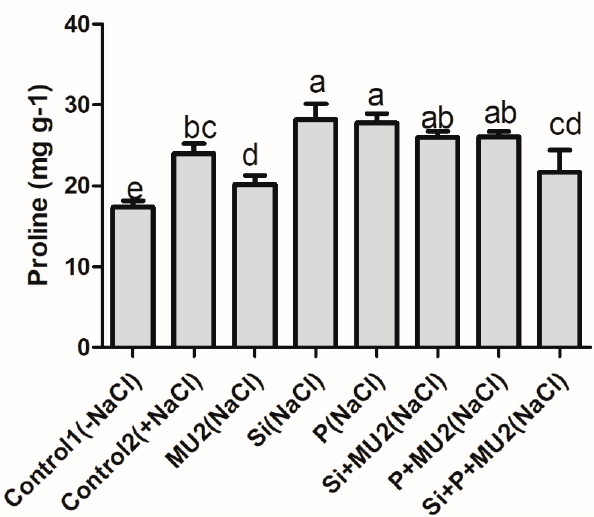
Figure 7. P. koreensis MU2 regulates proline content in soybean plants under stress. Error bars represent standard deviations. Each data point represents the mean of at least three replications. Bars with different letters are significantly different from each other at p ≤ 0.05.